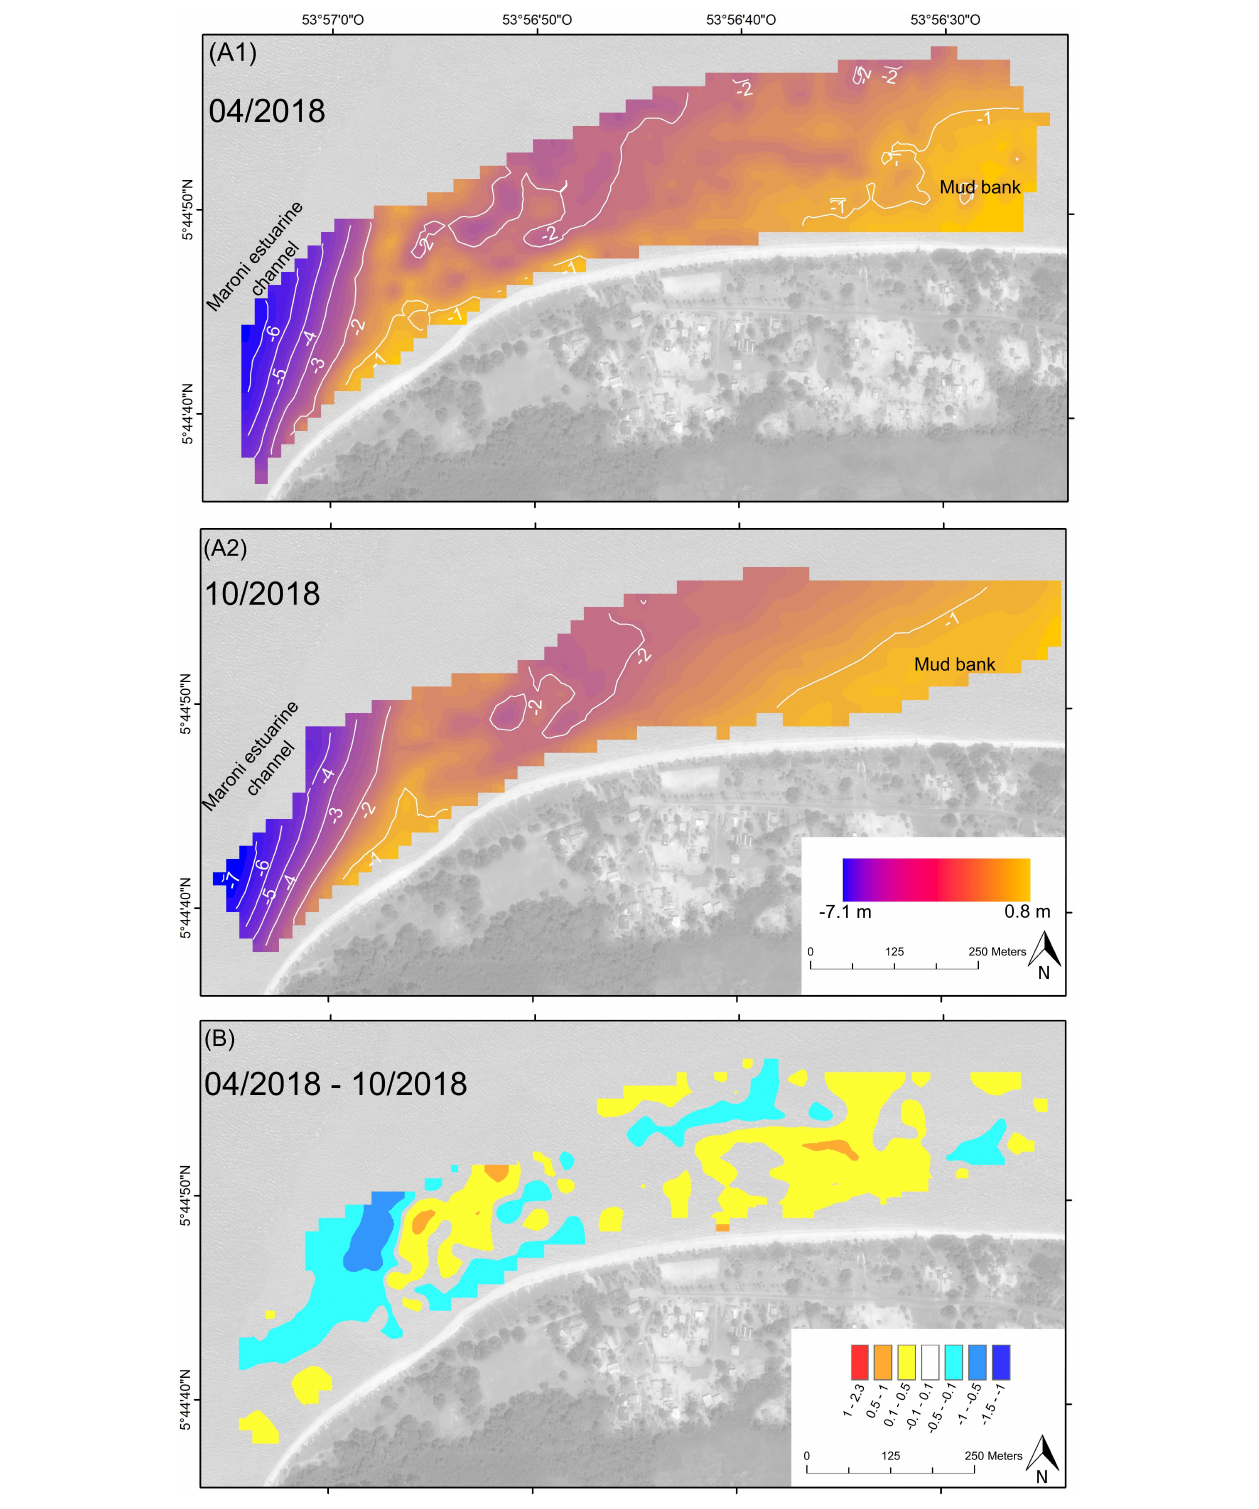
FIGURE 7 | DEMS of shoreface bathymetry adjacent to the beach (A1,A2) , and DoD over the study period, showing sediment loss close to the Maroni estuarine channel (B) .